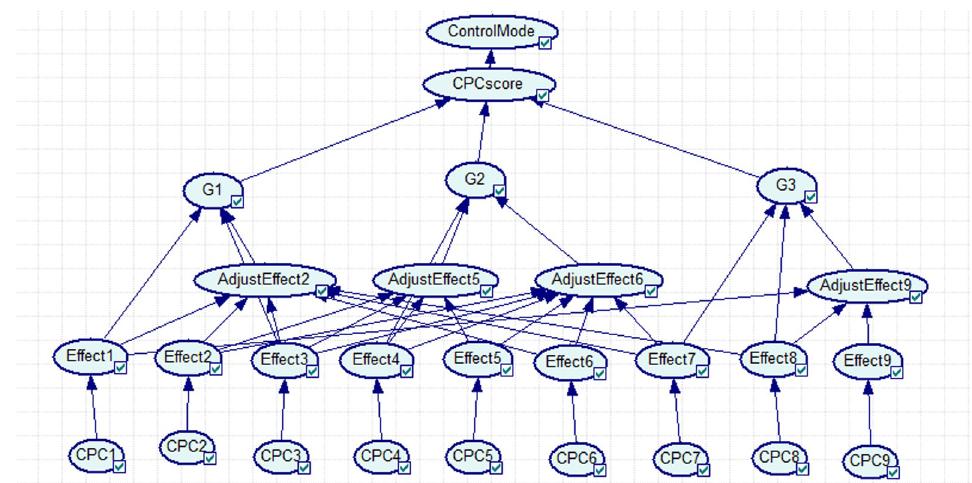
Fig 3. Using the BN for determining the probability distribution of the control modes.